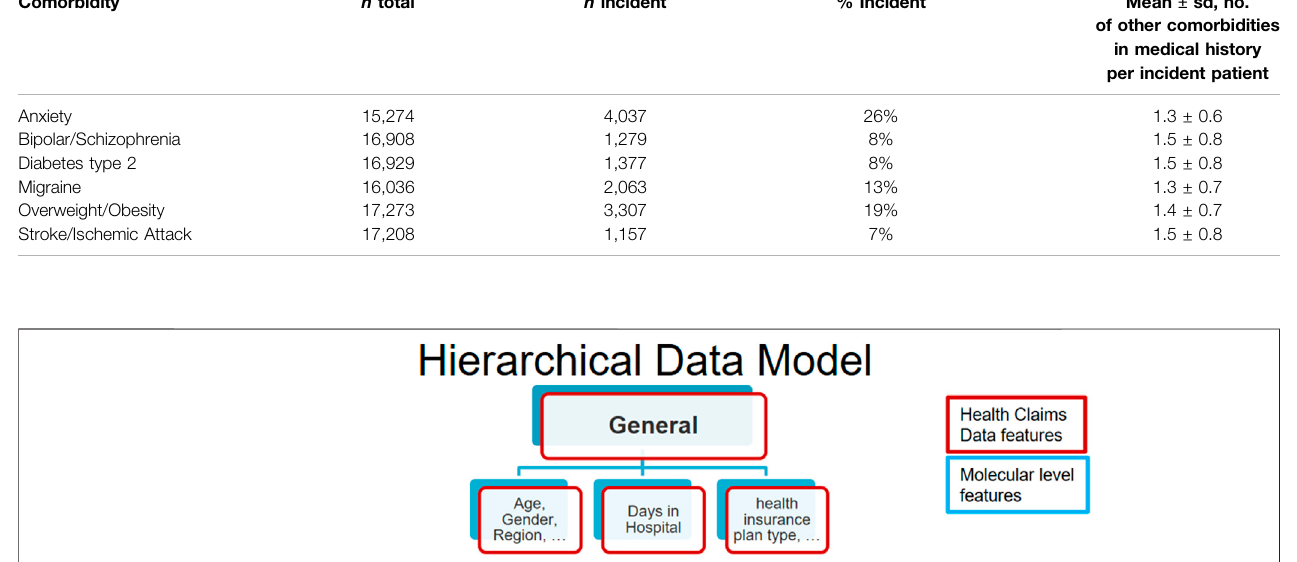
Frontiers in Arti fi cial Intelligence |